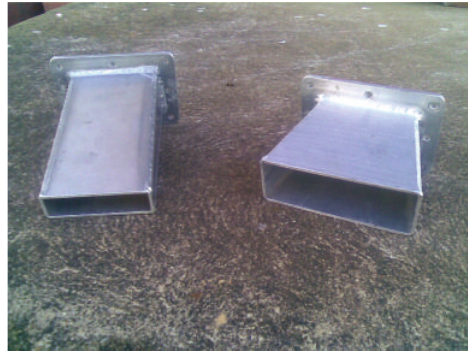
Figure 6: Horn antennas used in these microwave